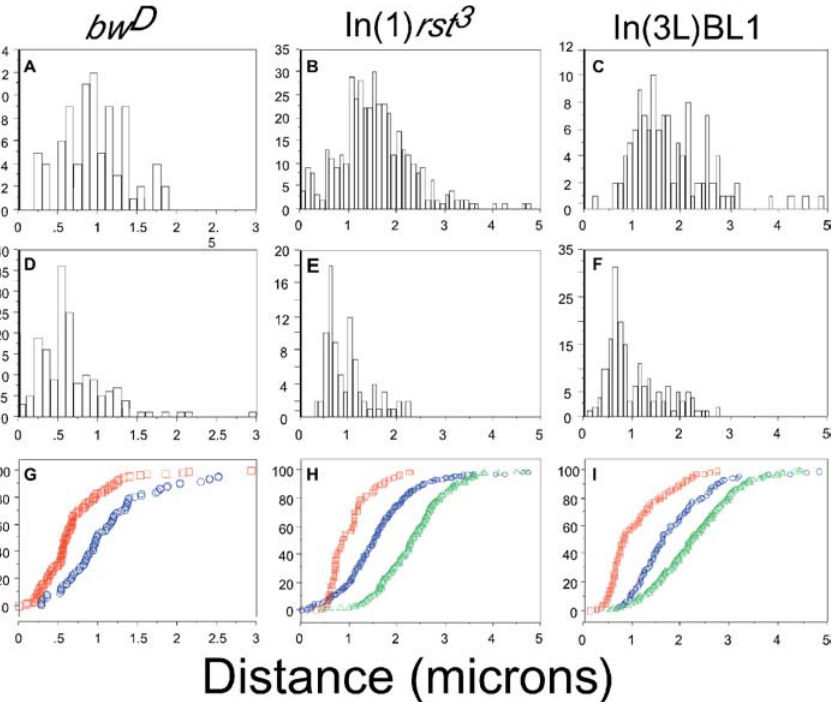
Figure 2. Silenced Genes Associate Tightly with Heterochromatin Physical distances in microns between heterochromatic sequences near each chromosome’s centromere and the variegating gene were measured and sorted based on expressing or non-expressing cells. (A–C) Expressing cells. (D–F) Silenced cells. (G–I) percentile plots of (A–F), in which blue represents expressing cells, red represents silenced cells, and green represents wild-type nuclei. bw D nuclei are Su( bw D )208 cells in adult eyes; In(1) rst 3 and In(3L)BL1 data are from imaginal eye